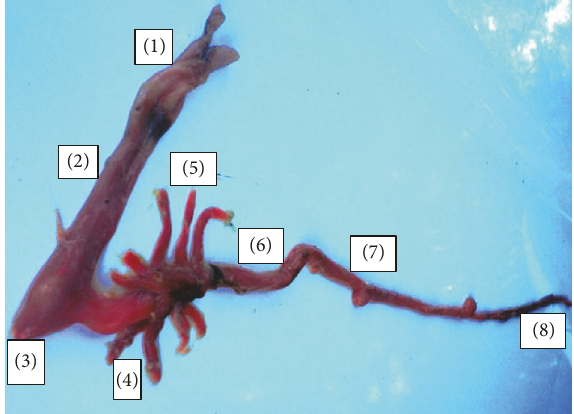
Figure 4: Structure of the digestive tract of A. baremoze . (1) Esophagus, (2) cardiac stomach, (3) fundic stomach, (4) pyloric stomach, (5) pyloric caeca, (6) anterior intestine, (7) mid intestine, and (8) posterior